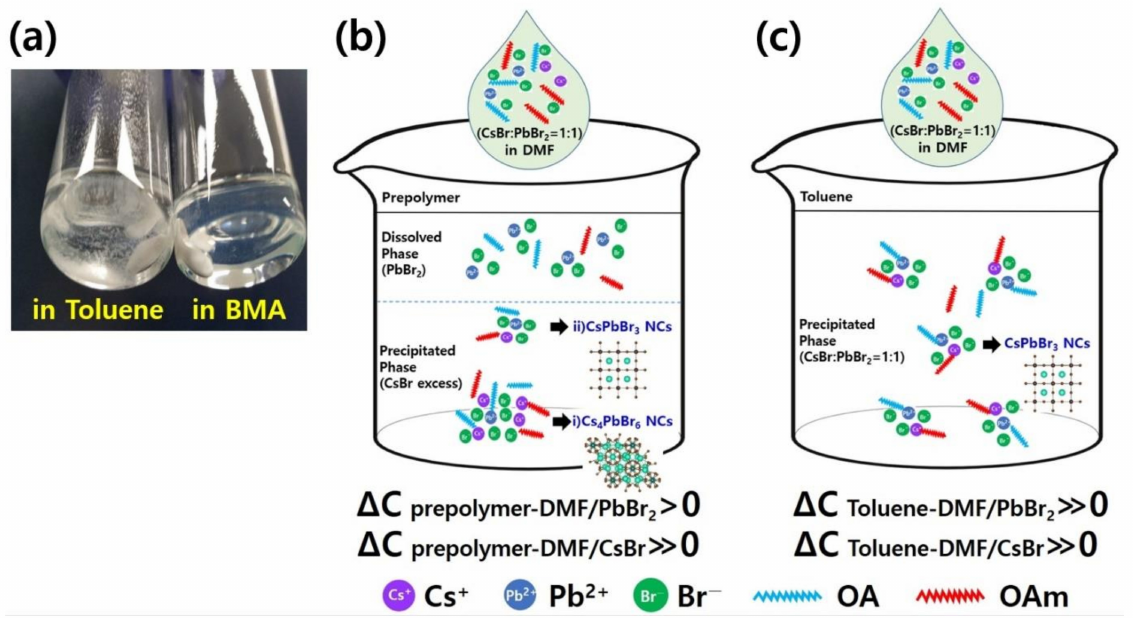
Figure 3. ( a ) Solubility test with 0.2 mL of the PbBr 2 –dimethylformamide (DMF) solution (0.2 mmol of PbBr 2 in 5 mL DMF) dropped into 5 mL of toluene or BMA solvent. Schematic of the formation mechanism for Cs 4 PbBr 6 and CsPbBr 3 in the ( b ) prepolymer and ( c ) toluene anti-solvent